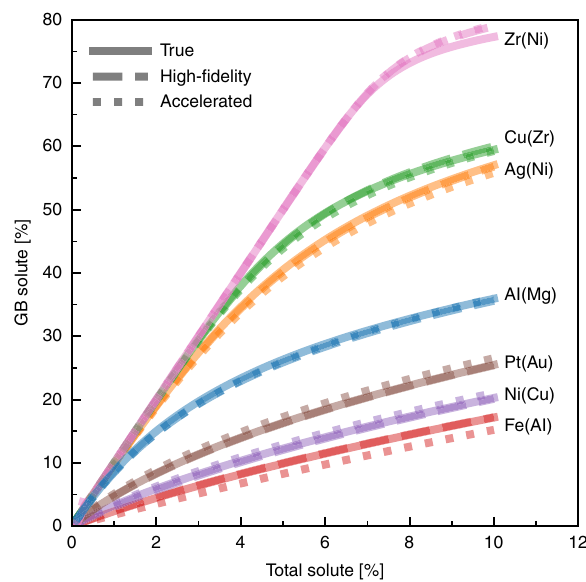
Fig. 5 Predictions of the equilibrium segregation state. Predictions of equilibrium (cid:1) X gb using the true, and predicted (from both high- fi delity and accelerated ML models) segregation spectra for seven polycrystalline alloys with an average grain size of 15 nm at T = 600